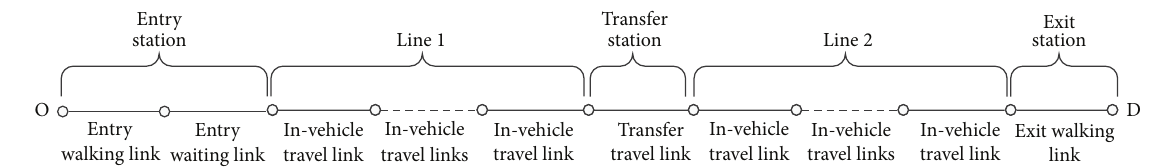
Figure 2: The example for the network used in this